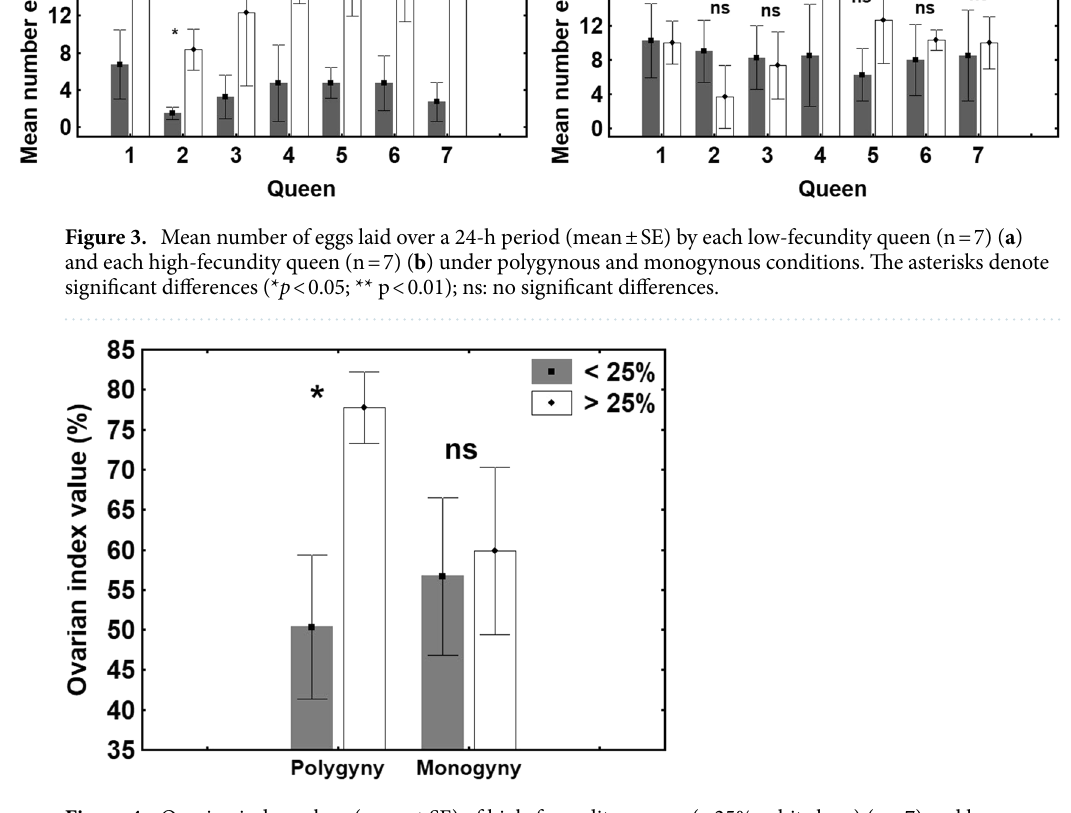
Figure 4. Ovarian index values (mean ± SE) of high-fecundity queens (> 25%; white bars) (n = 7) and low- fecundity queens (< 25%; grey bars) (n = 7) under polygynous and monogynous conditions. The asterisk denotes significant differences (* p < 0.05); ns: no significant